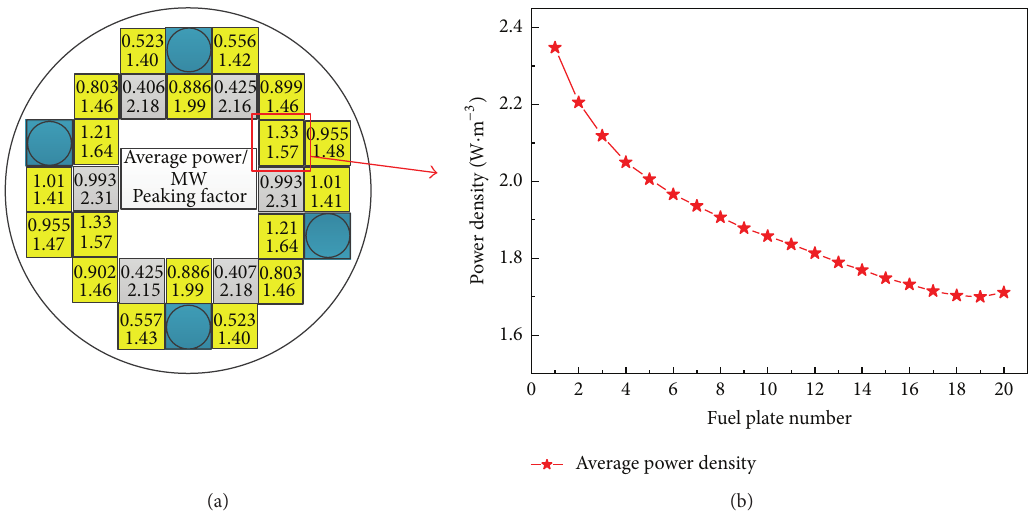
Figure 16: Location of hot assembly (a) and average power density distribution (b) in each fuel plate [20].